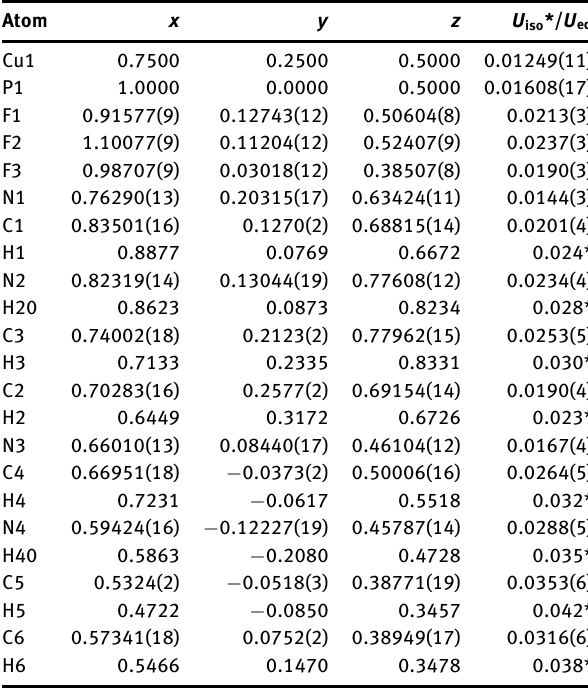
Table 2: Fractional atomic coordinates and isotropic or equivalent isotropic displacement parameters (Å 2